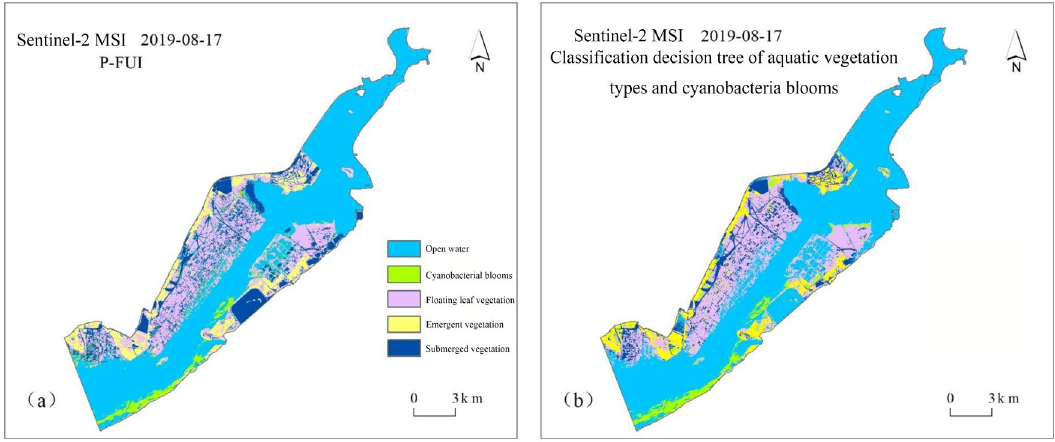
Figure 12. Comparison of CBs identification based on ( a ) P-FUI decision tree and ( b ) multi- exponential decision tree.